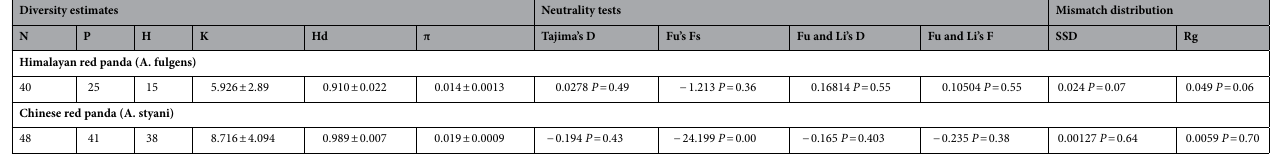
Table 2. Summary of genetic diversity indices and neutrality tests of demographic expansion of red panda populations. N—Number of samples; P—Polymorphic sites; H—Number of Haplotypes; K—Average number of nucleotide differences; Hd—Haplotypes diversity; π—Nucleotide diversity; Neutrality tests with P > 0.5; SSD—Sums of squared deviations; Rg—Harpending’ sraggedness index.